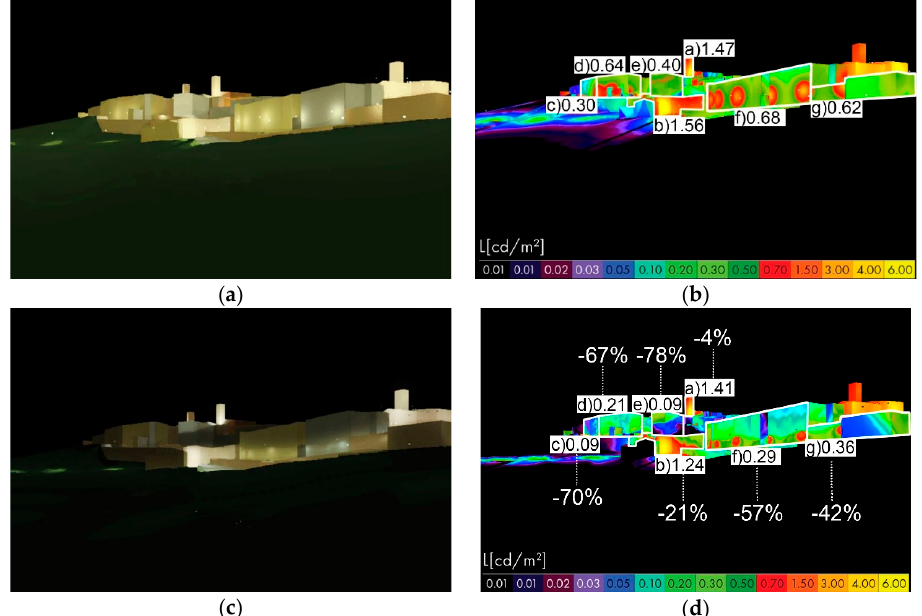
Figure 11. Observation point E2 (simulation performed using Dialux EVO software): ( a ) render of the ex-ante condition; ( b ) false colour render of the ex-ante luminance distribution. In evidence the analysed vertical surfaces and the corresponding average luminance values; ( c ) render of the ex-post condition; ( d ) false colour render of the ex-post luminance distribution. In evidence the analysed vertical surfaces, the corresponding average luminance values and the Relative Differences (RD) between the average luminance of the ex-ante and the ex-post installations.